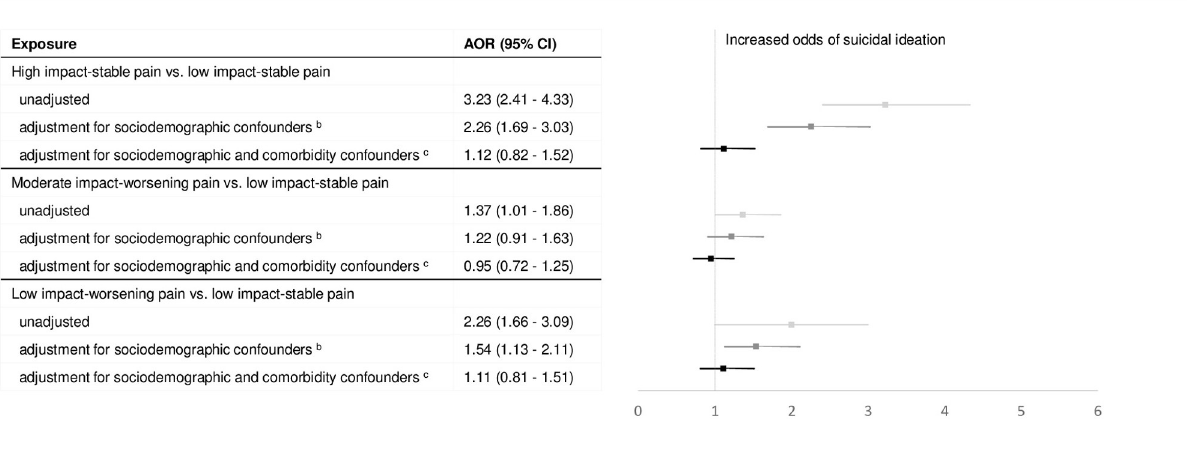
PLOS ONE | https://doi.org/10.1371/journal.pone.0267844 April 29,